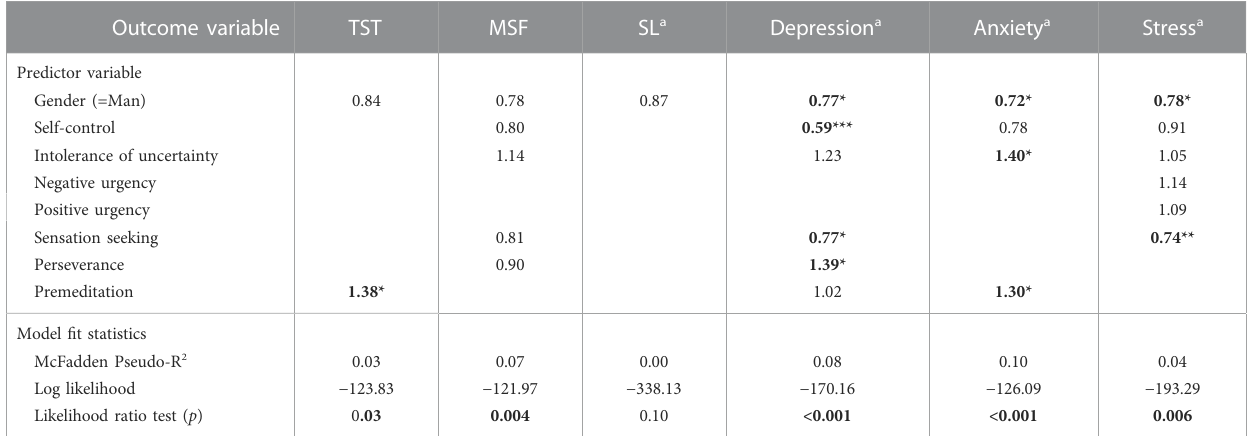
TABLE 5 Generalized linear model output for the prediction of sleep and mental